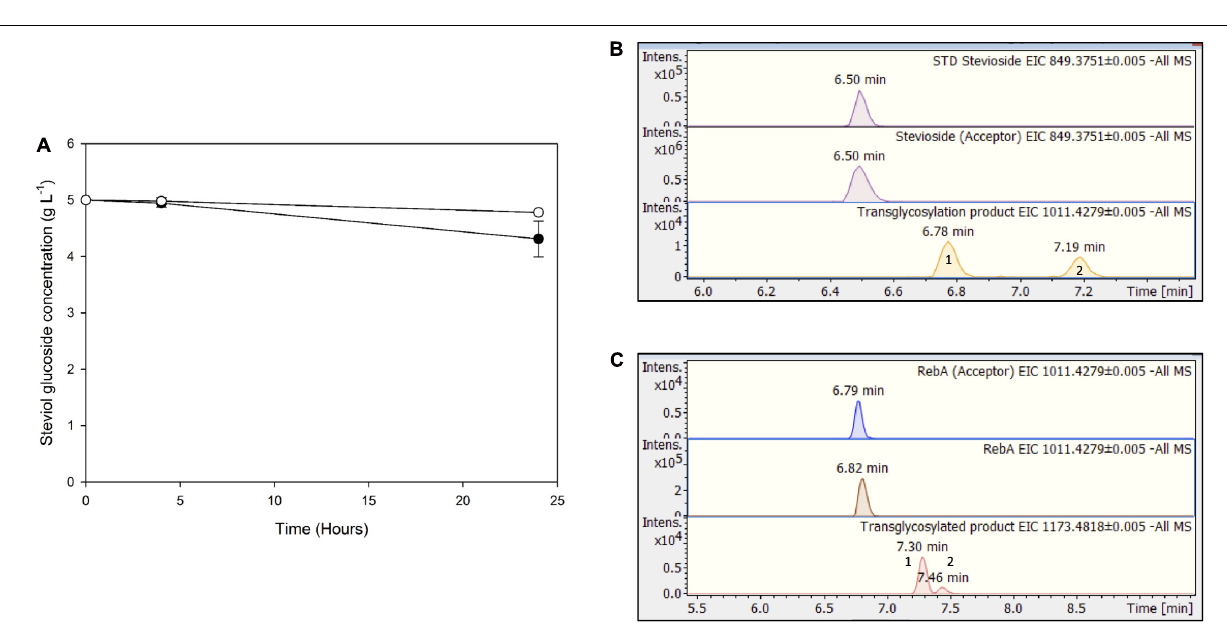
FIGURE 8 | (A) Transglycosylation of steviol glycosides by Mt Bgl3a with hydrolyzed microcrystalline cellulose as the donor. Black circles : stevioside, white circles : RebA. EICs of the detected transglycosylated products provided by HILIC-HRMS using as acceptor (B) stevioside (C)